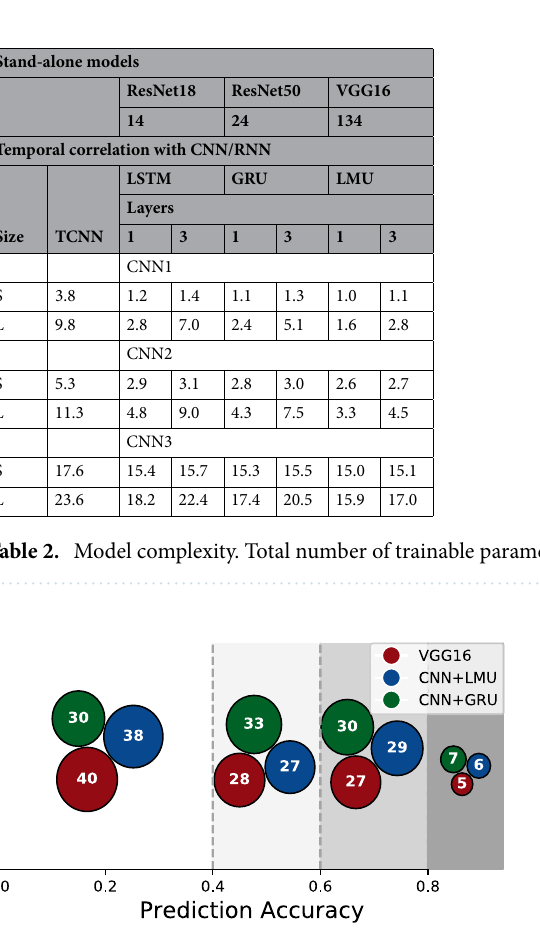
Figure 3. Class-wise predictions. We show, for VGG16, and the best CNN+GRU and CNN+LMU models (from Table 1), the number of classes that each model has the prediction accuracy in the given shaded brackets indicated along the x